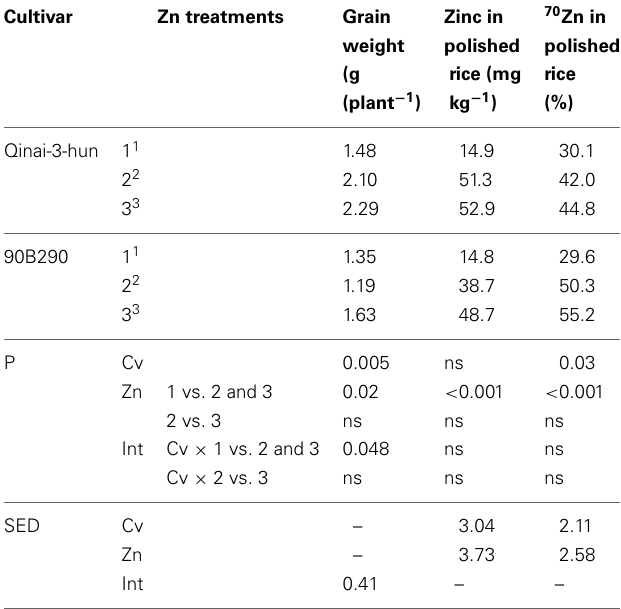
Table 1 | Grain weight per plant (brown rice), total Zn concentrations in the polished (white) rice and 70 Zn (% of total Zn) observed for three treatments imposed on two cultivars (cv) (Experiment